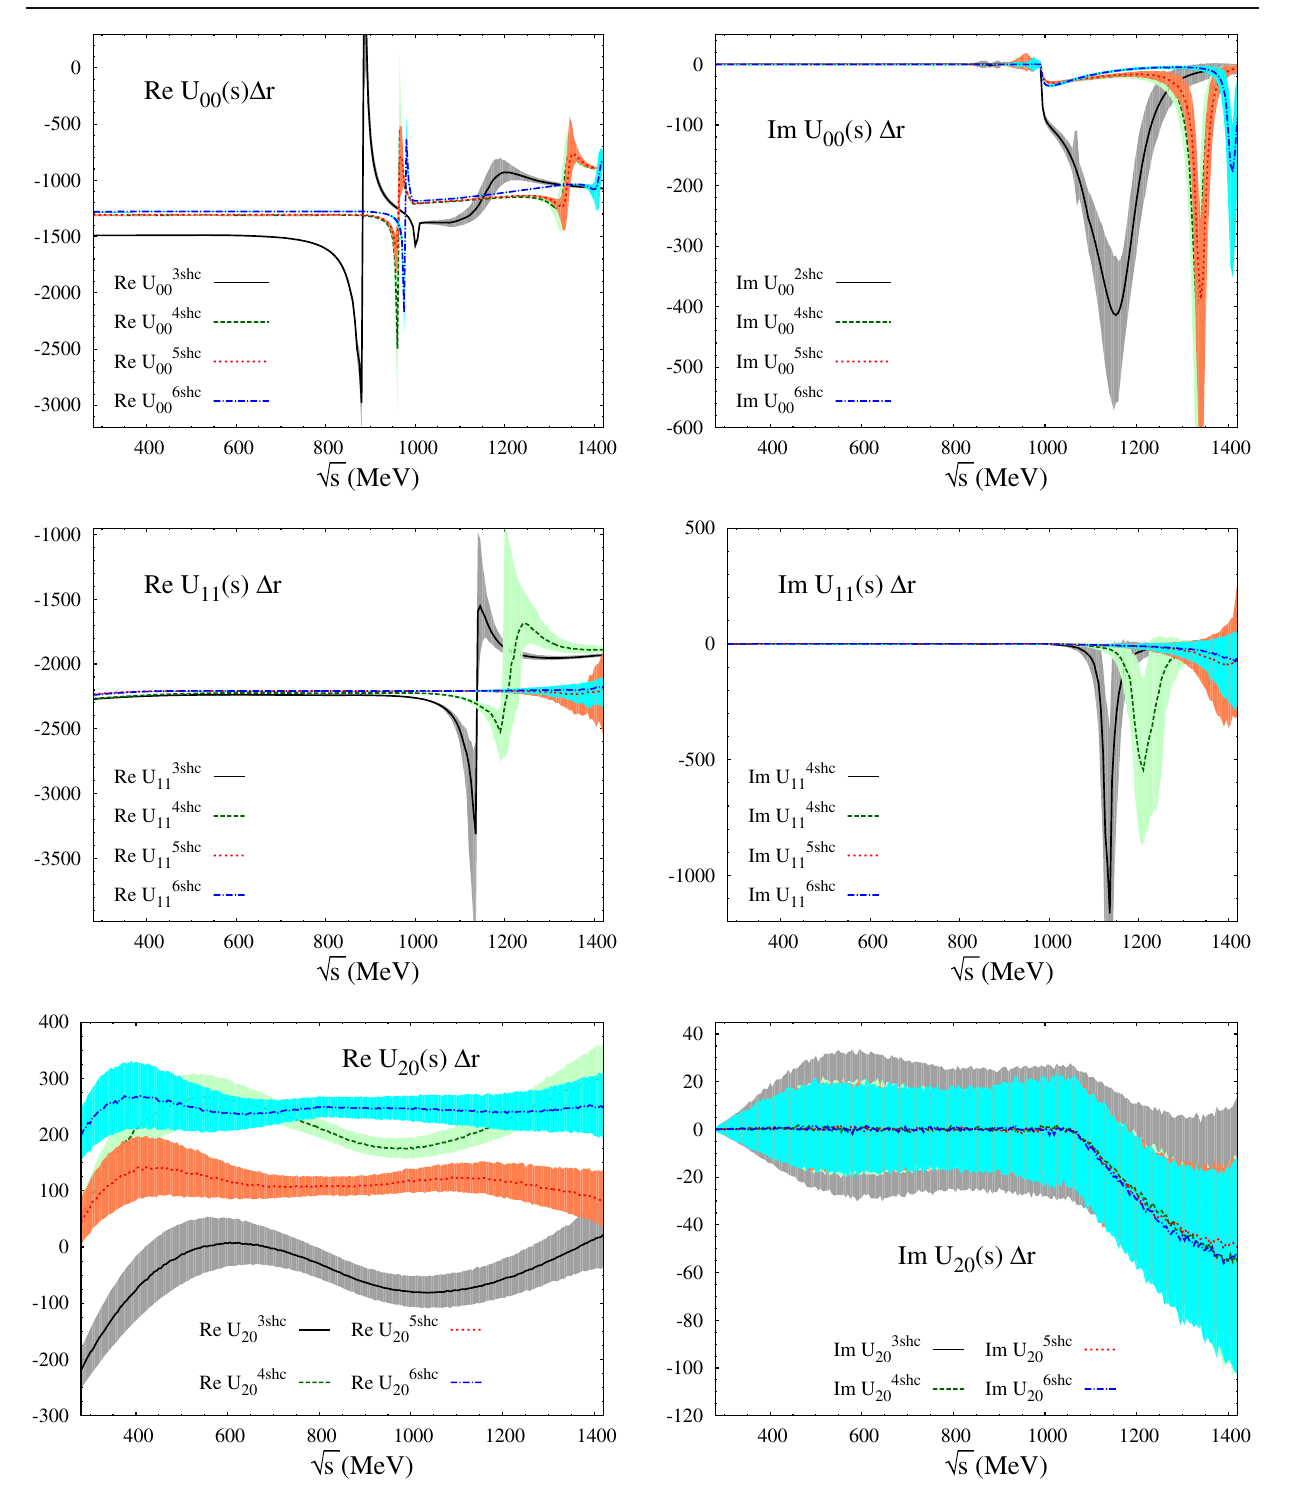
Fig. 12 Real and imaginary part of the inner delta-shell potential for the S0, P and S2 partial waves whereas solid-black, green-dashed, red- dottedandbluedot-dashedlinescorrespondtotheresultswith r c = 0 . 9, 1 . 2, 1 . 5 and 1 . 8 fm, respectively. The error bands have been computed